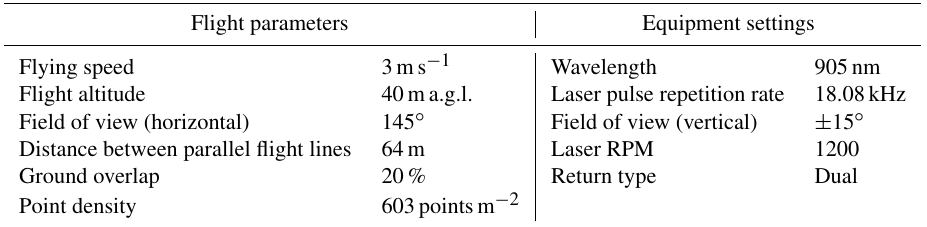
Table 2. Flight parameters and equipment